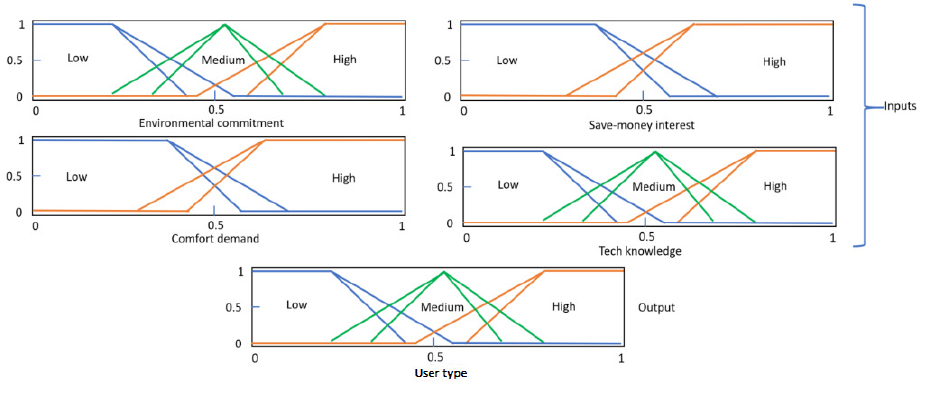
Figure 4. Fuzzy logic type II membership